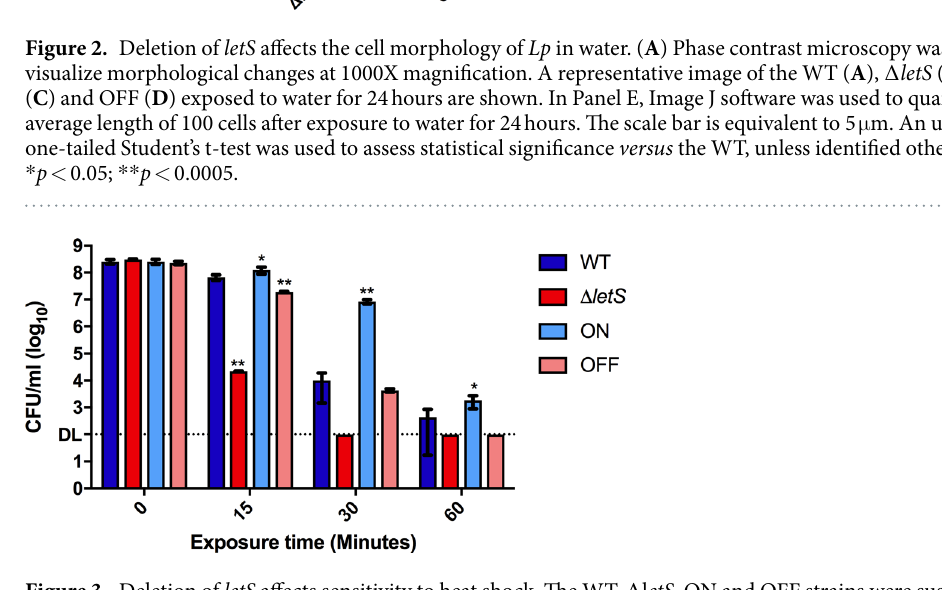
most affected by LetS were those associated with exponential growth or nutrient rich conditions and were mostly negatively affected by LetS in water (Fig. 6). These include “Translation”, “Amino acid metabolism”, “Lipid metab- olism” and “Energy metabolism”. Notably, 30 of the 38 “Translation” genes that are normally down-regulated by